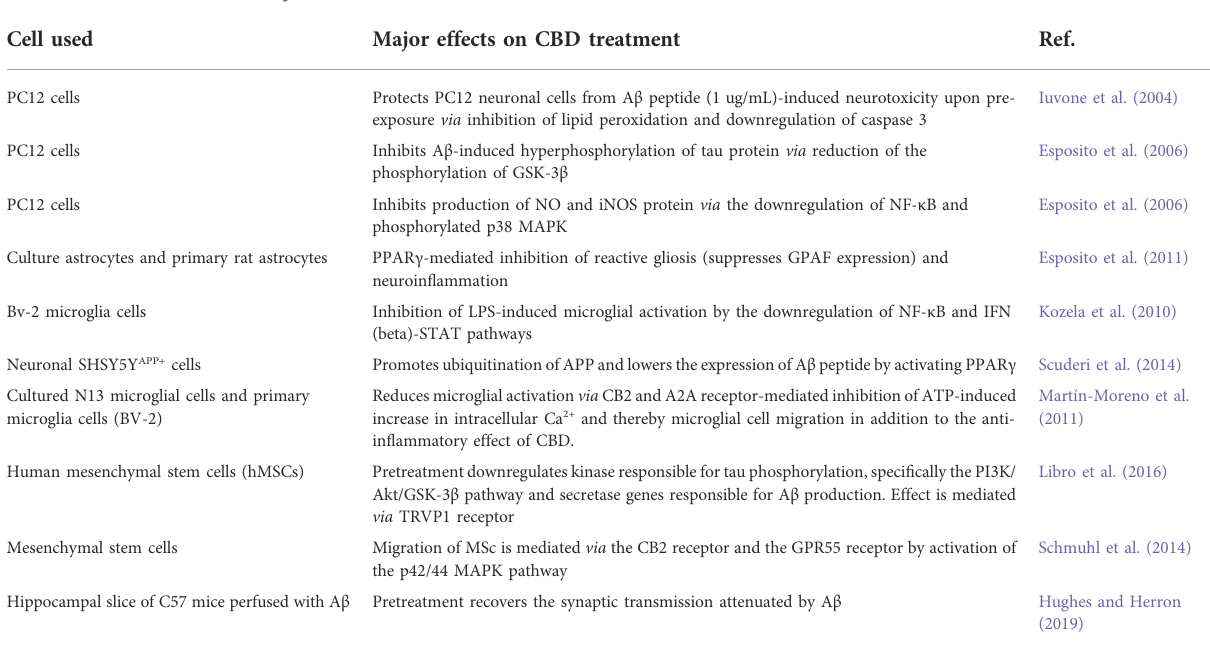
TABLE 2 CBD on AD, in vitro